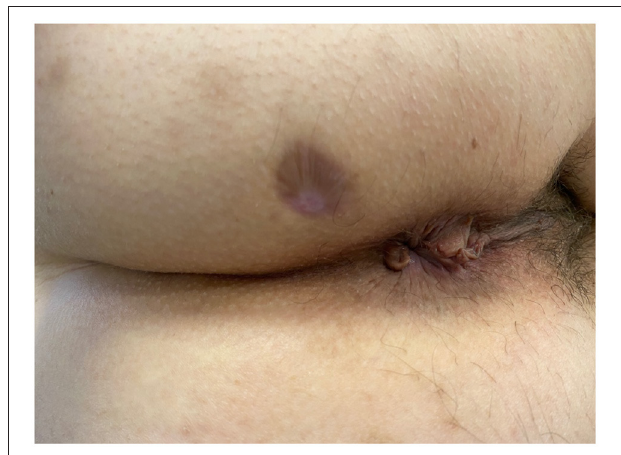
FIGURE 2 | Patient A—View of the perianal area 7 months after HAM implantation. The external orifice is completely scarred and